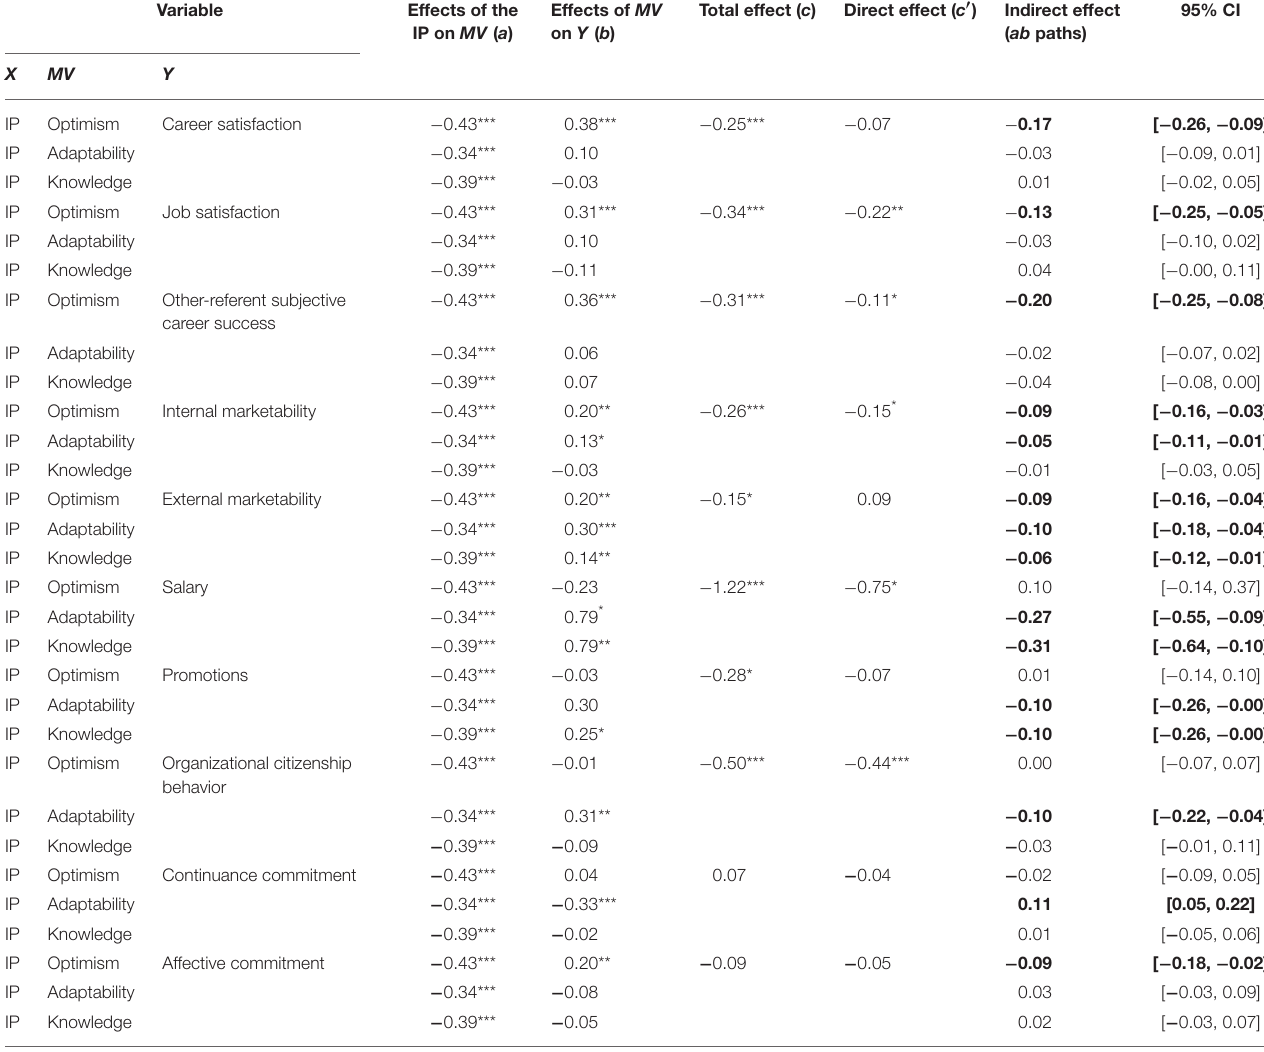
TABLE 3 | Mediating effects of CSM factors (MVs) in the relationship between the IP (X) and work-relevant outcomes (Y). Variable Effects of the Effects of MV Total effect ( c IP on MV ( a ) on Y ( b )